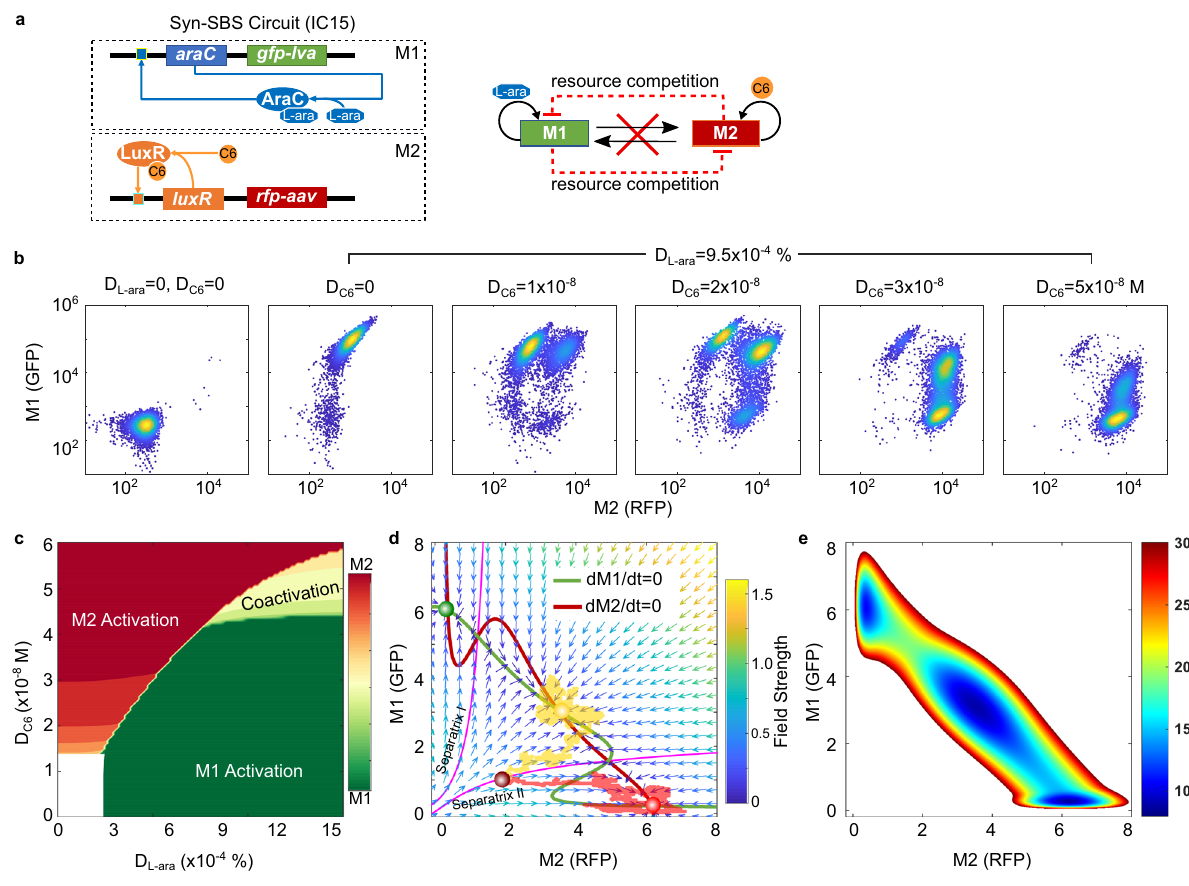
Fig. 3 Resource competition between two separate bistable switches. a Diagram of the two separate bistable switches (Syn-SBS). b Flow cytometry data show cell state transitions with an increasing level of inducer C6 (D C6 ) and a fi xed dose of L-ara ( D L-ara = 9.5 × 10 − 4 %). In total, 10,000 events were recorded for each sample. The two inducers were both added at 0 h. Data from one representative of three independent biological replicates. c Cell fates in the space of two inducers L-ara and C6 at addition time 0 h. d Simulated stochastic trajectories highlighted on the phase plane diagram. The nullclines of M1 and M2 are shown in green and red, respectively, while separatrices are shown in pink. The vector fi eld of the system is represented by small arrows, where the color is proportional to the fi eld strength. The three cell fates (red, green, and yellow circles) are found at the intersections of the two nullclines. Two representative single-cell stochastic trajectories (yellow and red highlights) show the evolution of the system from the same initial condition (purple circle, D L-ara = 0%, and D C6 = 0 M) to two different states with the same induction ( D L-ara = 9.5 × 10 − 4 % and D C6 = 5 × 10 − 8 M). e Calculated potential landscape. Circuit IC15 was used here. Source data are provided as a Source Data fi